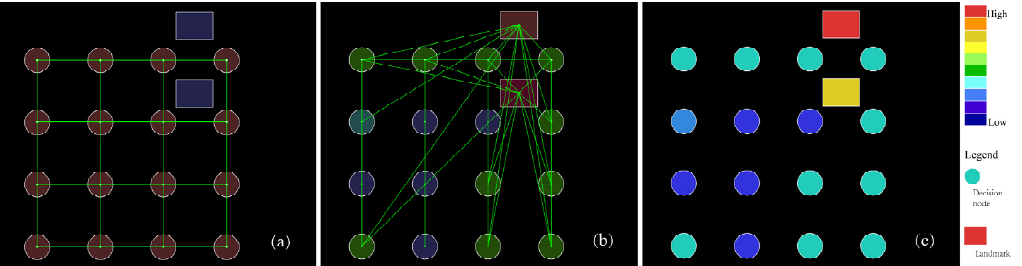
Figure 6. Space syntax computation. ( a ) Nodes are unlinked with landmarks, ( b ) landmarks are linked with nodes, ( c ) the NAIN values of each node in the 3D NL GAM.